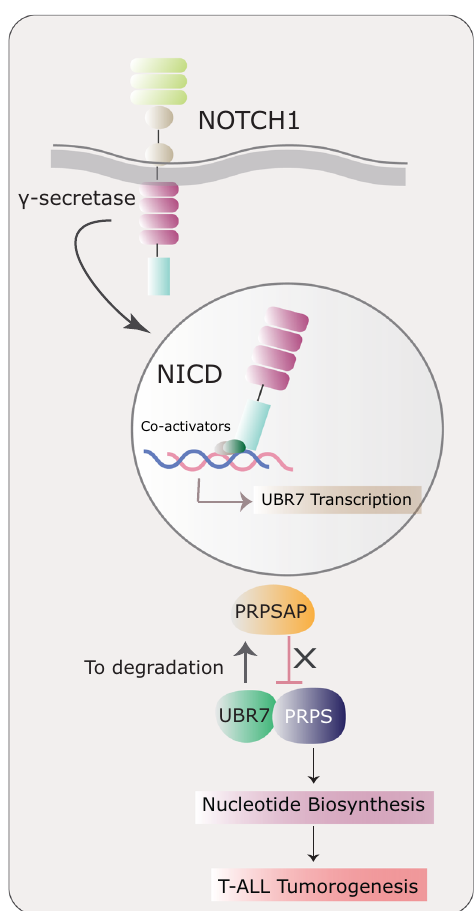
Fig. 1 Nucleotide biosynthesis regulation by UBR7 in T-ALL. A model depicting the generation of NICD and its translocation to the nucleus from the proteolytic cleavage of NOTCH1 receptor by gamma secretase. NICD transcriptionally activates UBR7. UBR7 stabilizes the PRPS enzymes by promoting the degradation of PRPSAP. Stabilization of PRPS catalyzes the nucleotide biosynthesis and promotes T-ALL. In absence of UBR7, PRPSAP inhibits PRPS enzymes resulting in suppression of nucleotide biosynthesis and T-ALL progression. (NICD NOTCH intracellular domain; UBR7 ubiquitin protein ligase E3 component N-recognin 7; PRPS phosphoribosyl pyrophosphate synthetase; PRPSAP phosphoribosyl pyrophosphate synthetase associated protein; T-ALL T acute lymphoblastic